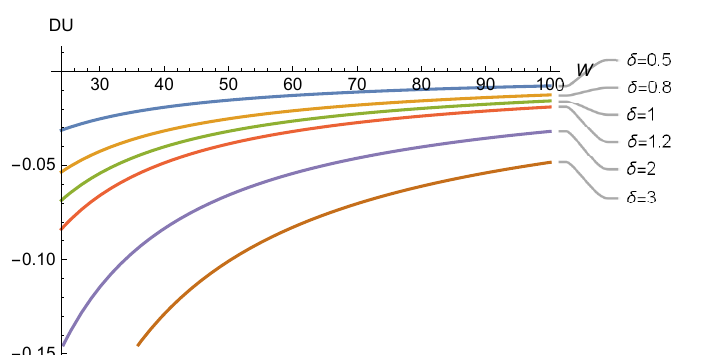
Figure 1. DU ( W ) δ for a = 0.5,1,1.5,2.5,3.8.